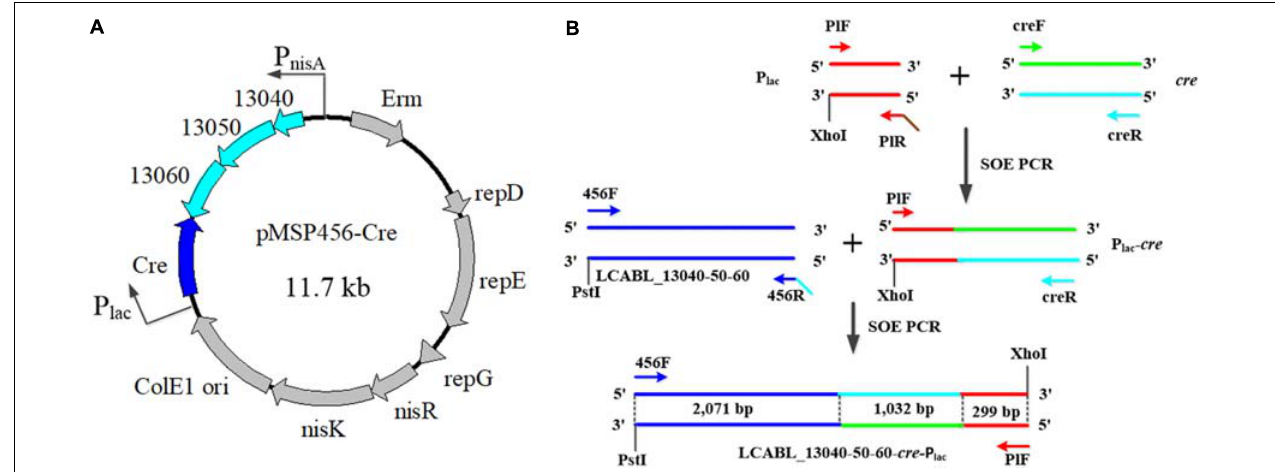
FIGURE 1 | Scheme of plasmid pMSP456-Cre (A) and the construction of the cassette LCABL_13040-50-60 - cre -P lac (B) . 13040, 13050, and 13060 indicated the LCABL_13040, LCABL_13050 and LCABL_13060, respectively. P nisA , nisin promoter. P lac , lactose operon promoter. Erm, erythromycin resistance gene. SOE PCR, gene splicing by overlap extension PCR. NisR, a response regulator. NisK, a sensor kinase. LCABL_13040-50-60 indicated the recombinase operon. PlF/PlR, creF/creR, 456F/456R refer to PCR primers and that the sequences are provided in Table 2 .